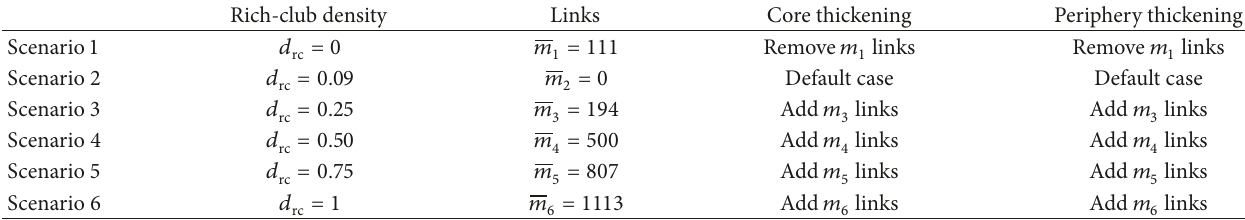
Table 2: Simulation scenarios for core and periphery thickening.